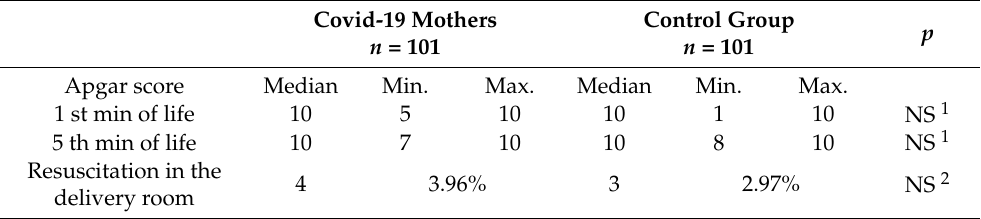
Table 2. Comparison of the Apgar score and the need for resuscitation in the study group and control group.